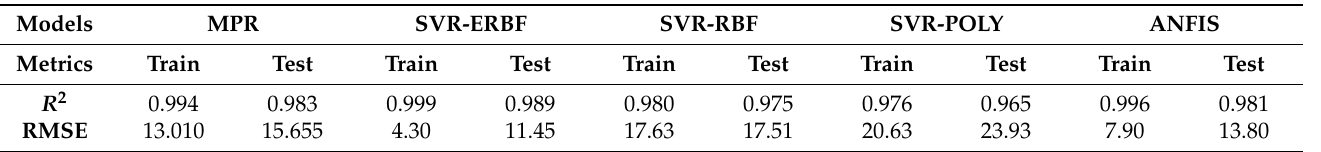
Table 4. Evaluating the performance of the MPR model vs. prior black-box models for predicting the bearing